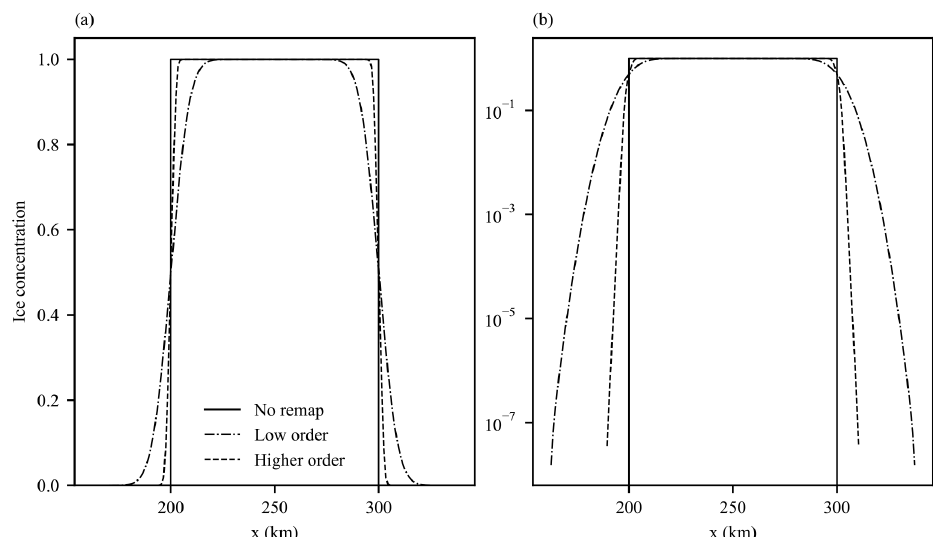
Figure 2. (a) Final ice concentration for the one-dimensional top hat test case. No remapping (solid), low-order remapping, and higher- order (dashed) remapping. (b) As (a) but with a logarithmic ordinate axis. Results for no remapping, low-order remapping, and higher-order remapping are